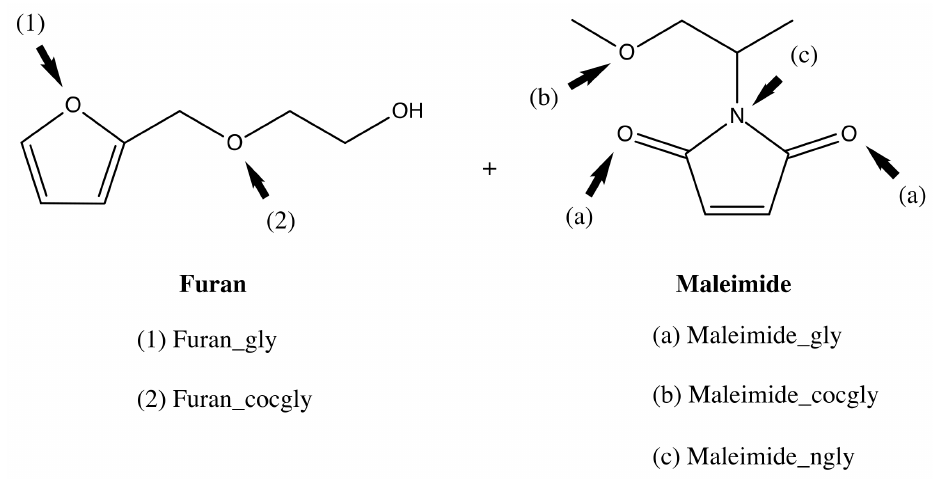
Figure 4. Coordination sites for the glycol group in Furan and Maleimide and their